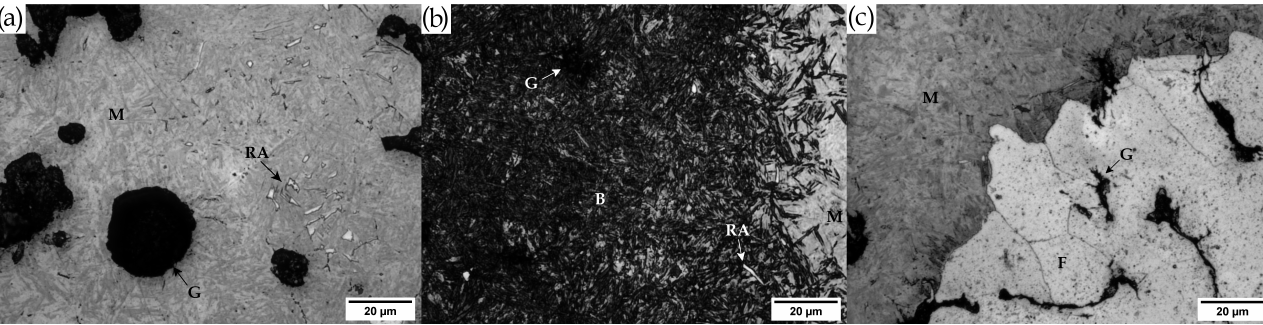
Figure 2. Microstructure of the samples quenched in water after 15 min of annealing at 880 ◦ C. ( a ) Martensite with some retained austenite. ( b ) Bainite next to a martensitic area. ( c ) Ferrite grains and martensite. G: Graphite; F: Ferrite; M: Martensite; B: Bainite; RA: Retained